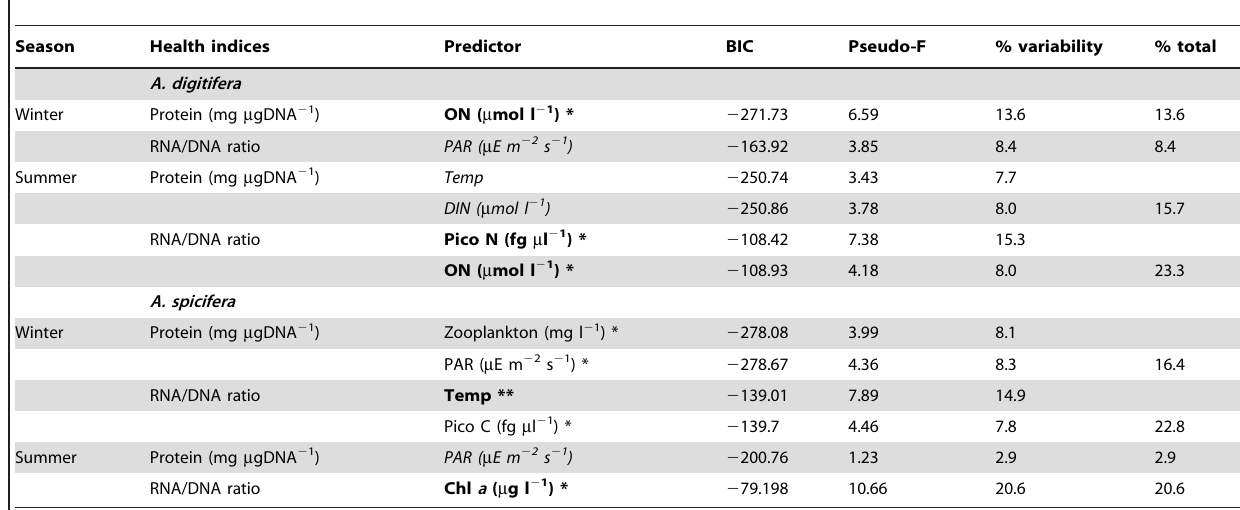
Table 1. Physico-chemical predictors for variation in protein concentration and RNA/DNA ratio in A. digitifera and A. spicifera during winter (August 2010) and summer (February